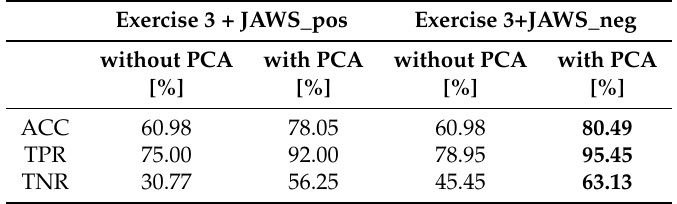
Table 6. Evaluation of the k-means classifier for separate Job-related Affective Well-being Scale (JAWS)